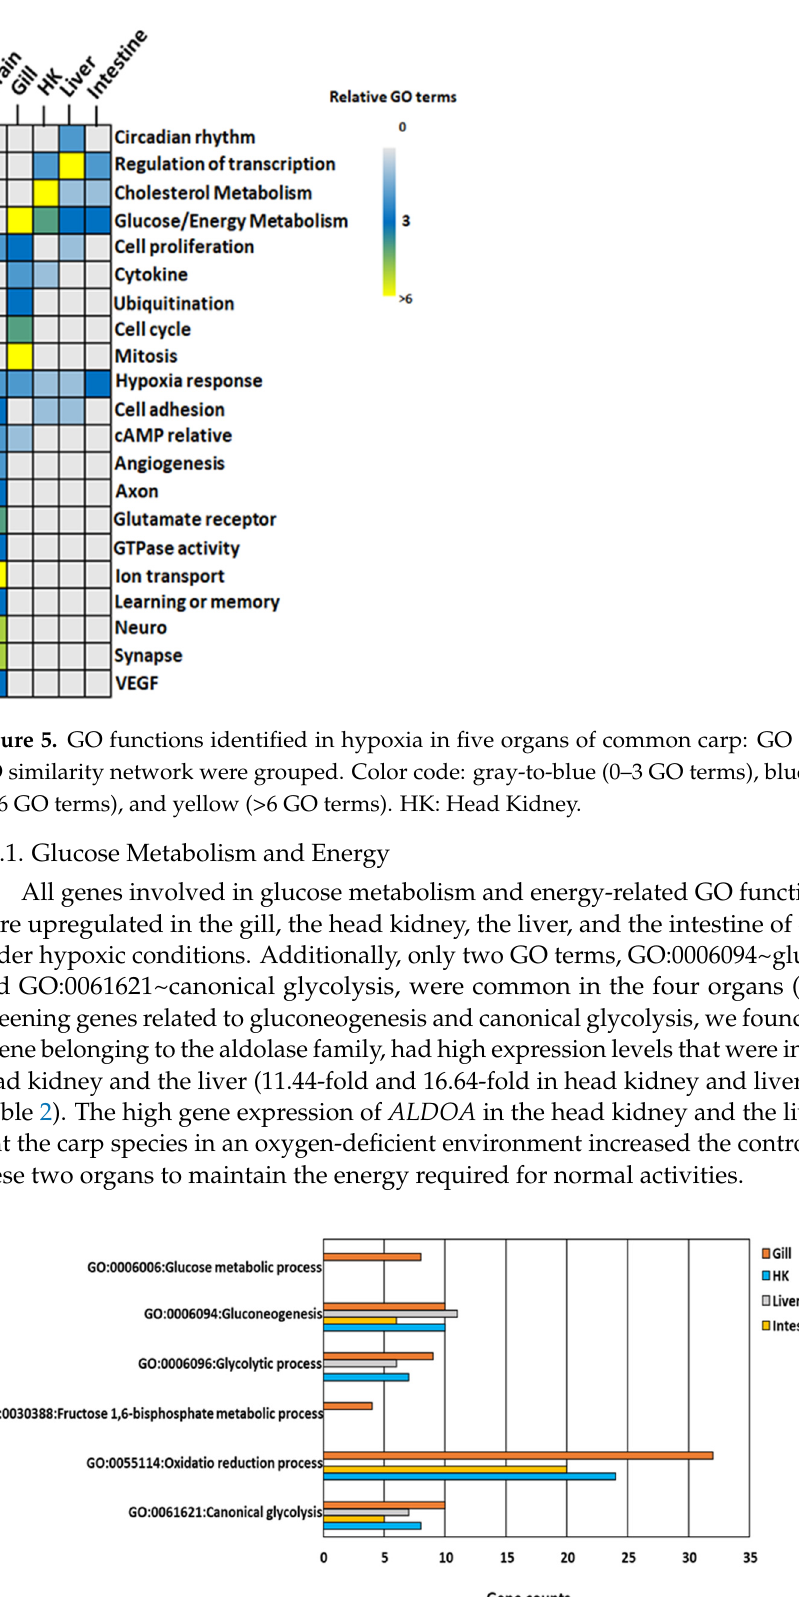
Figure 4. GO similarity network analysis of common carp gills in hypoxia: The three similarity scores and three association scores were computed for each GO term pair, and a bubble network map was created.